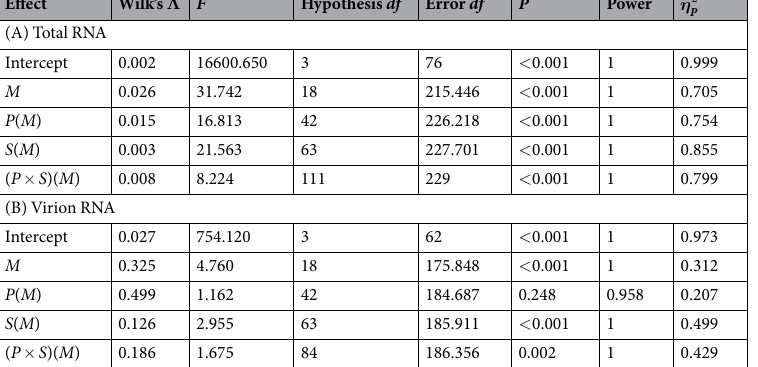
among the four sample types taken from each one of the three different plants inoculated with the same mixture of RNAs (factor ( P × S )( M )). However, a significant P -value tells nothing about the magnitude of the effect that a factor has on the measured variables; a small effect may still be significant from an statistical point of view, while being too small to be biolog- and among equivalent samples from different plants (( P × S )( M ) term in equation (1)) and that the effect associ-